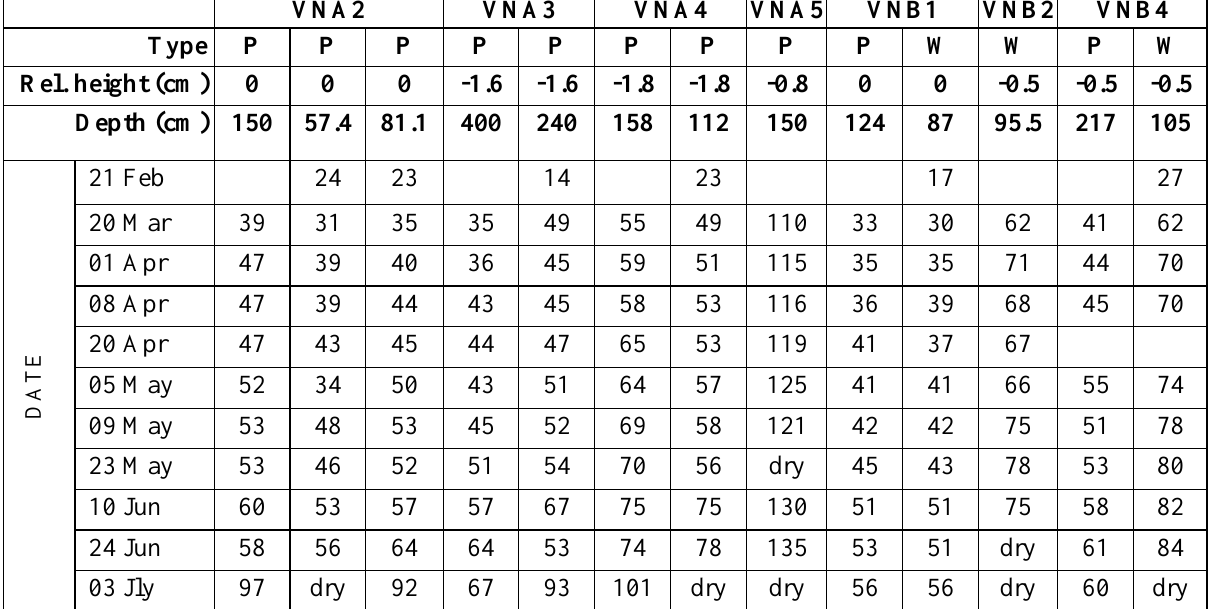
Table A4. Water levels (cm below ground surface) measured in the groundwater tubes (P = piezometer, W = (perforated) dipwell) during the period February–July 2015. Depth refers to the bottom of the